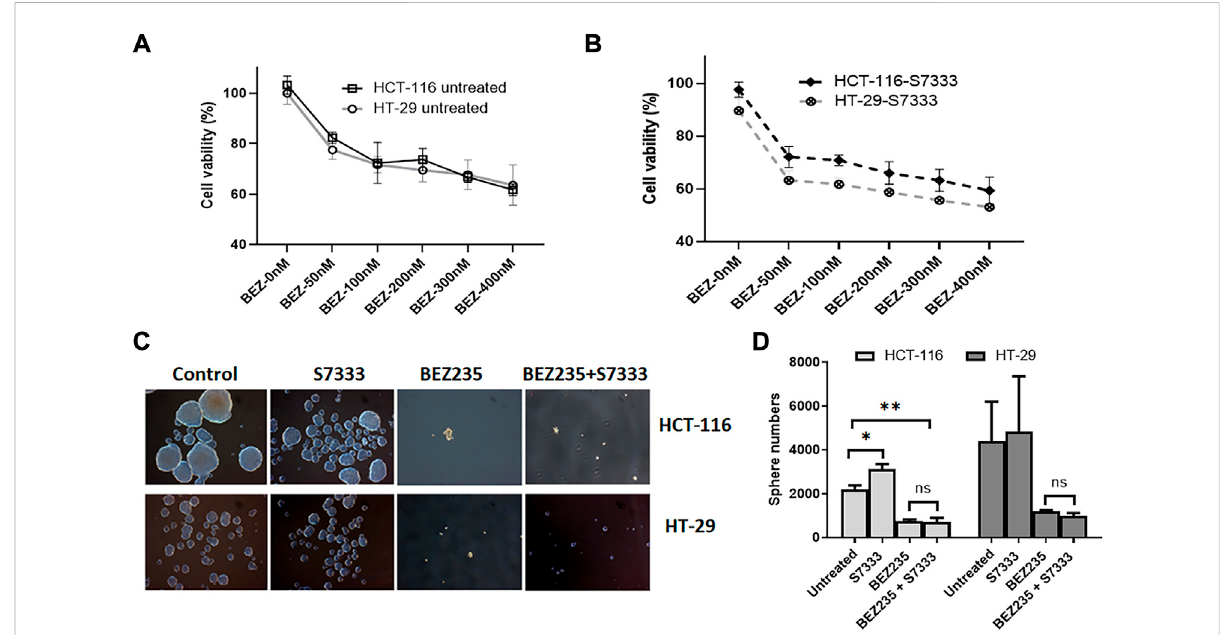
BEZ235 can equally inhibit the cancer stemness in HCT-116 and HT-29 cells. Cell viability assay of MTT shows that both HCT-116 and HT-29 cells exhibit asimilar dose-dependent decrease as BEZ235 dose increases (A) . After S7333treatment, theystill exhibit thedose-dependentdecrease ofcellviability thoughHT-29cellsareslightlymoresensitive thanHCT-116 (B) ,buttherearenostatisticaldifferencesbetweenthesetwocelllinesat any doses. The sphere numbers were remarkably decreased after BEZ235 treatment with or without S7333 blocking the K-Ras G13D mutation